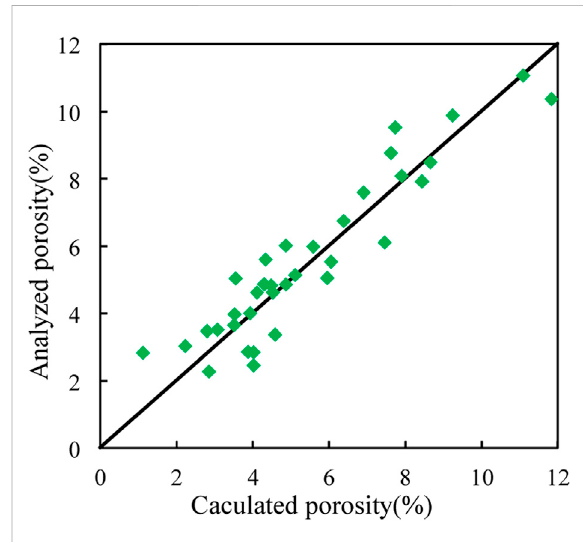
FIGURE 14 Crossplot between core analysis and calculated porosity.